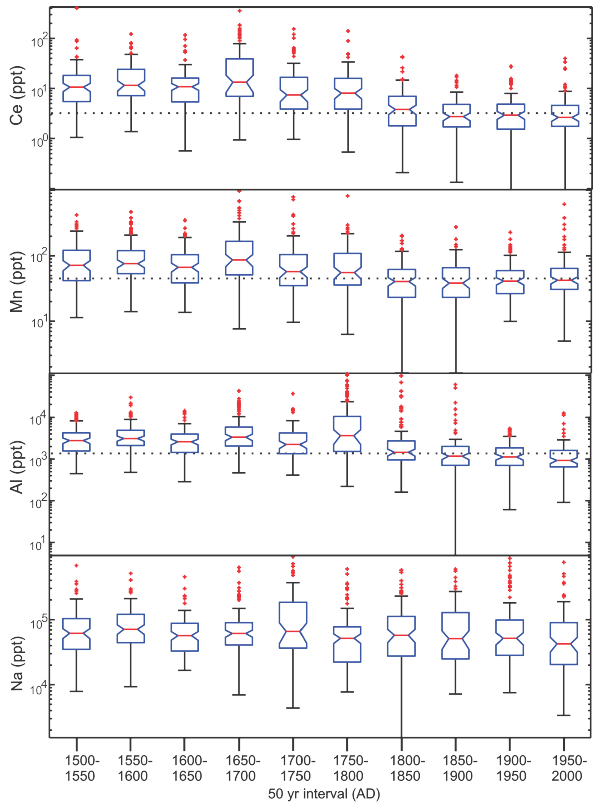
Figure 7: Notched boxplots of chemical element concentrations (resampled to 2 samples yr –1 ) 1 Fig. 7. Notched boxplots of chemical element concentrations (re- for 50 yr intervals of the MES record. The extent of the blue box defines the inter-quartile 2 sampled to 2 samplesyr − 1 ) for 50-yr intervals of the MES record. range (IQR) and the red horizontal line is the median value. Medians values of two time 3 The extent of the blue box defines the inter-quartile range (IQR), and the red horizontal line is the median value. Medians values of intervals are significantly different (p < 0.05) if boxplot notches around the median lines do 4 two time intervals are significantly different ( p < 0.05) if boxplot not overlap. Black whiskers denote range of 1.5*IQR and datapoints that lie outside this 5 notches around the median lines do not overlap. Black whiskers de- range are defined as statisical outliers (red crosses). 6 note range of 1.5 × IQR, and data points that lie outside this range are defined as statistical outliers (red crosses). Horizontal black dot- ted line locates upper edge of notch for 1850–1900AD interval.